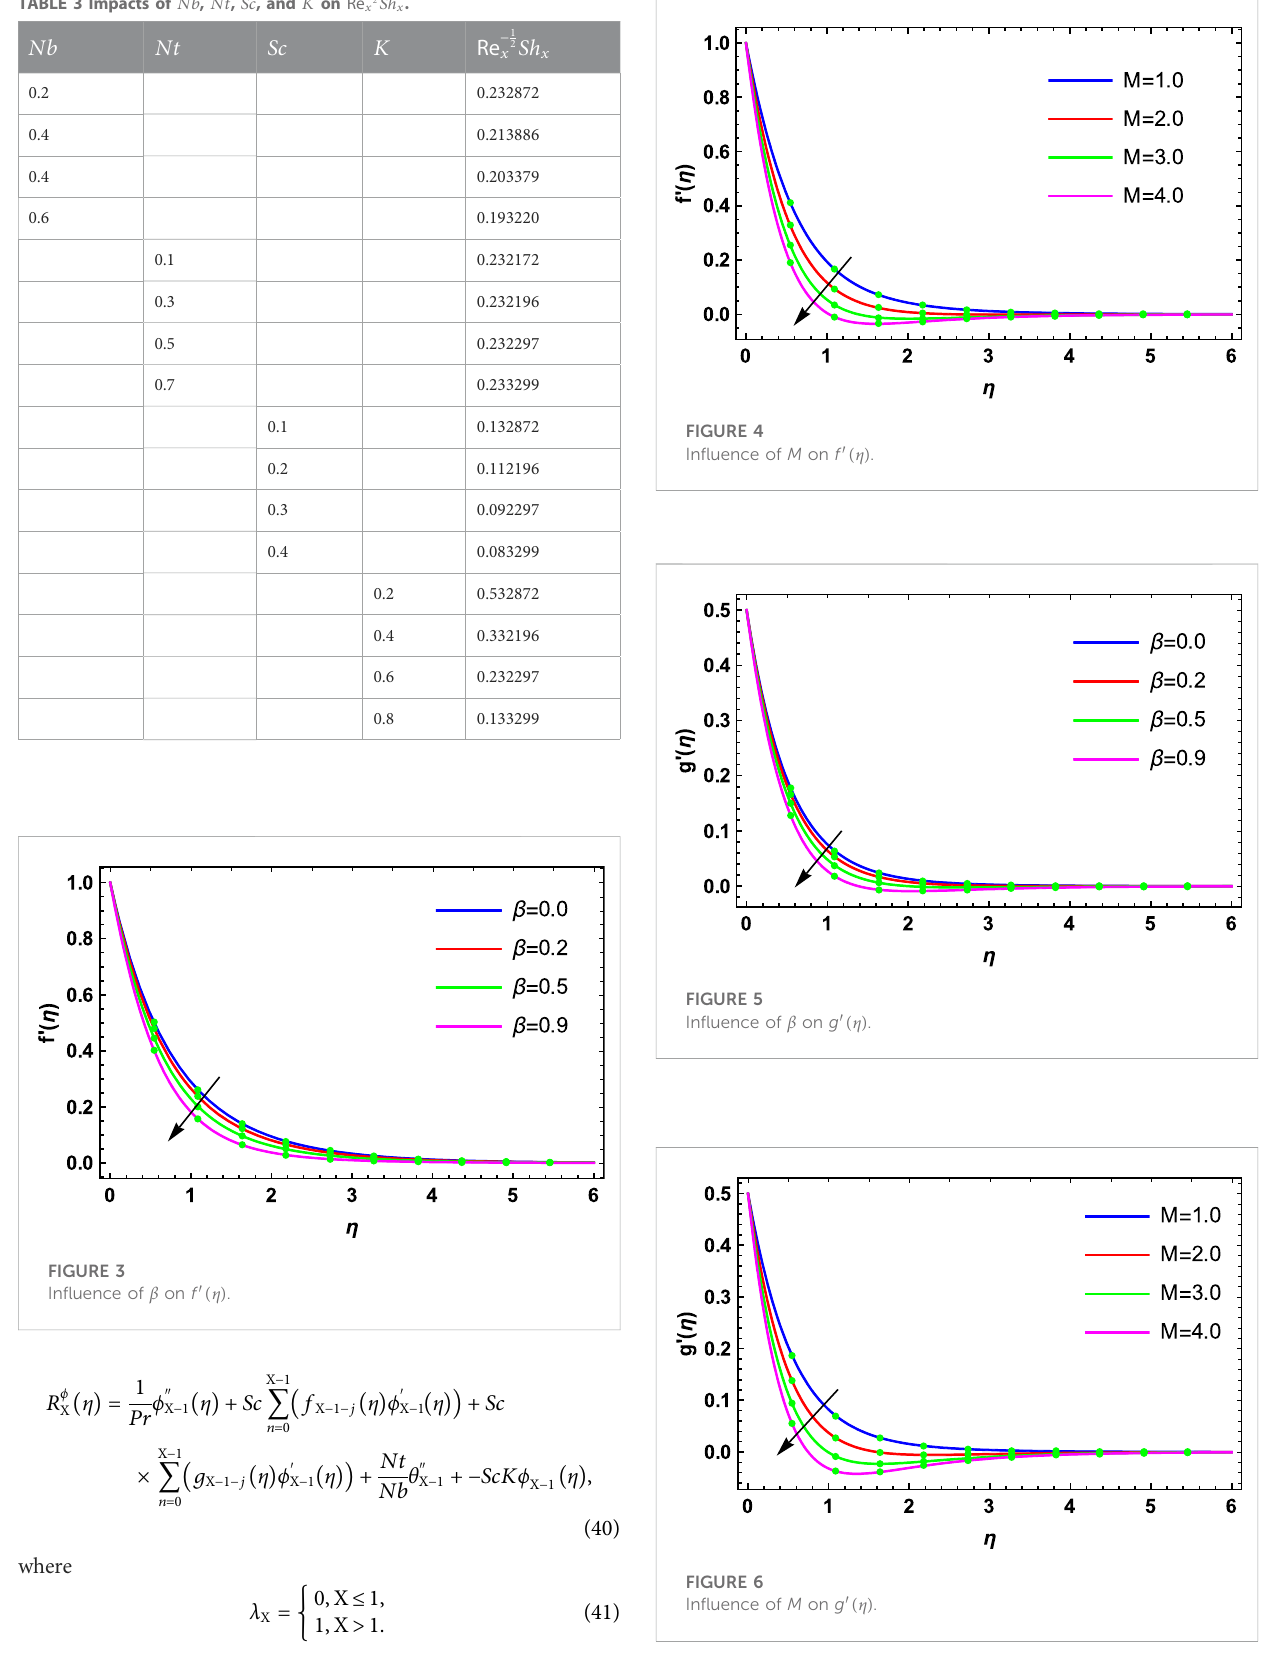
In fl uence of M on g ′ ( η )